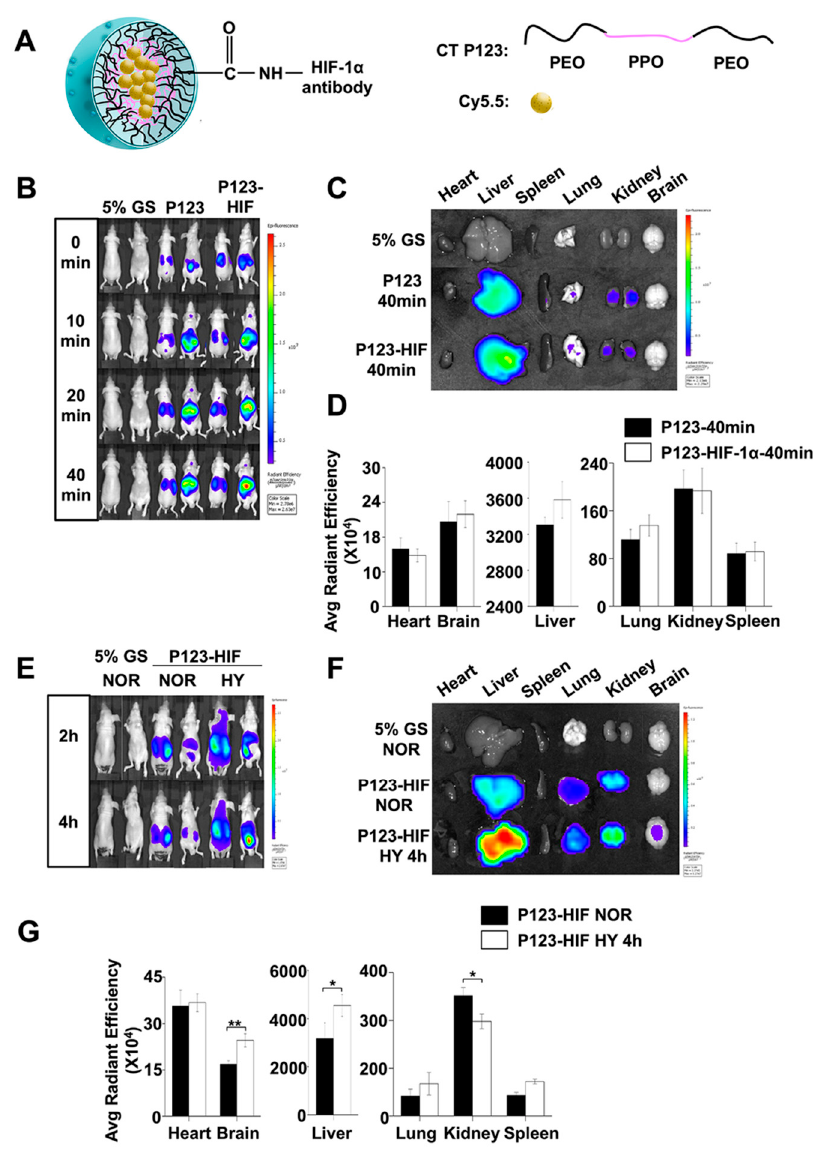
Figure 2. In vivo and in vitro fluorescence imaging of HIF-1 α accumulation after hypoxic exposure. ( A ) Schematic representation of the synthesis of Pluronic P123 copolymer and strategy of modification of HIF-1 α antibody. The left figure shows the structure of the nanocomposite of anti-HIF-1 α -NMs-cy5.5; the right figure displays the carboxylic acid on the terminal end of the PEO which is conjugated to anti-HIF-1 α by carbodiimide coupling chemistry. CT P123, carboxyl-terminated Pluronic P123 nano micelles; PEO, poly (ethylene oxide); PPO, poly (propylene oxide). ( B ) The metabolic kinetics of the nanocomposites in vivo was first tested before the hypoxia experiment. Fluorescence images were taken at 0, 10, 20 and 40 min after injection of anti-HIF-1 α -NMs-cy5.5. After injection for 40 min, a strong and stable near-infrared fluorescence signal was observed. Mice injected with of glucose solution (GS) and NMs-cy5.5 (P123) served as controls. ( C ) In vitro fluorescence images of the organs excised from body 40 min after injection of nanocomposites. ( D ) Quantification of the nano-carriers accumulated in different organs ( n = 3). ( E ) In vivo fluorescence imaging was performed in nude mice when strong and stable NIRF signal was observed. GS group: mice were injected with 5% glucose solution; NOR group: mice were injected with P123-HIF (anti-HIF-1 α -NMs-cy5.5 nanocomposites) under normoxia condition; HY group: mice were exposed to 8% O2. ( F ) In vitro fluorescence images of the organs 4 h after hypoxia exposure. ( G ) Quantification of the nano-carriers accumulated in different organs after hypoxia ( n = 3). *, p < 0.05, **, p < 0.01. The error bars represent SEM.